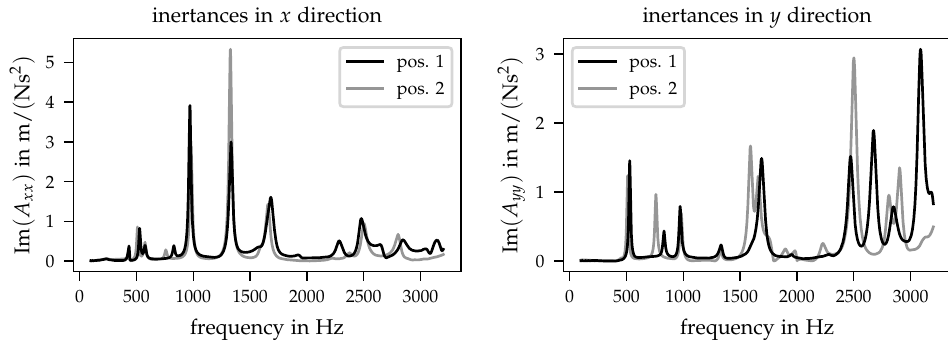
Figure 8. Comparison of driving point inertances for different preload positions and preload level at approx. 50N. ( left ) Imaginary part of input inertances A xx . ( right ) Imaginary part of input inertances A yy .